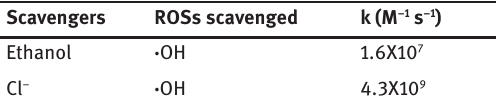
nanoparticles 2